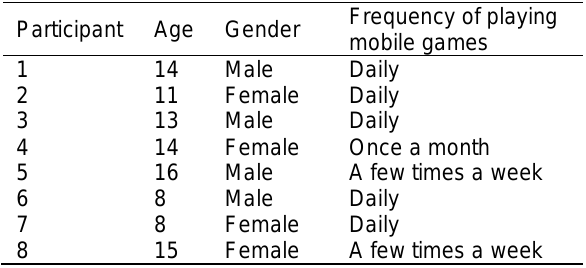
Table 2. Participant Overview Table 3. Summary of Cancer Knowledge Survey